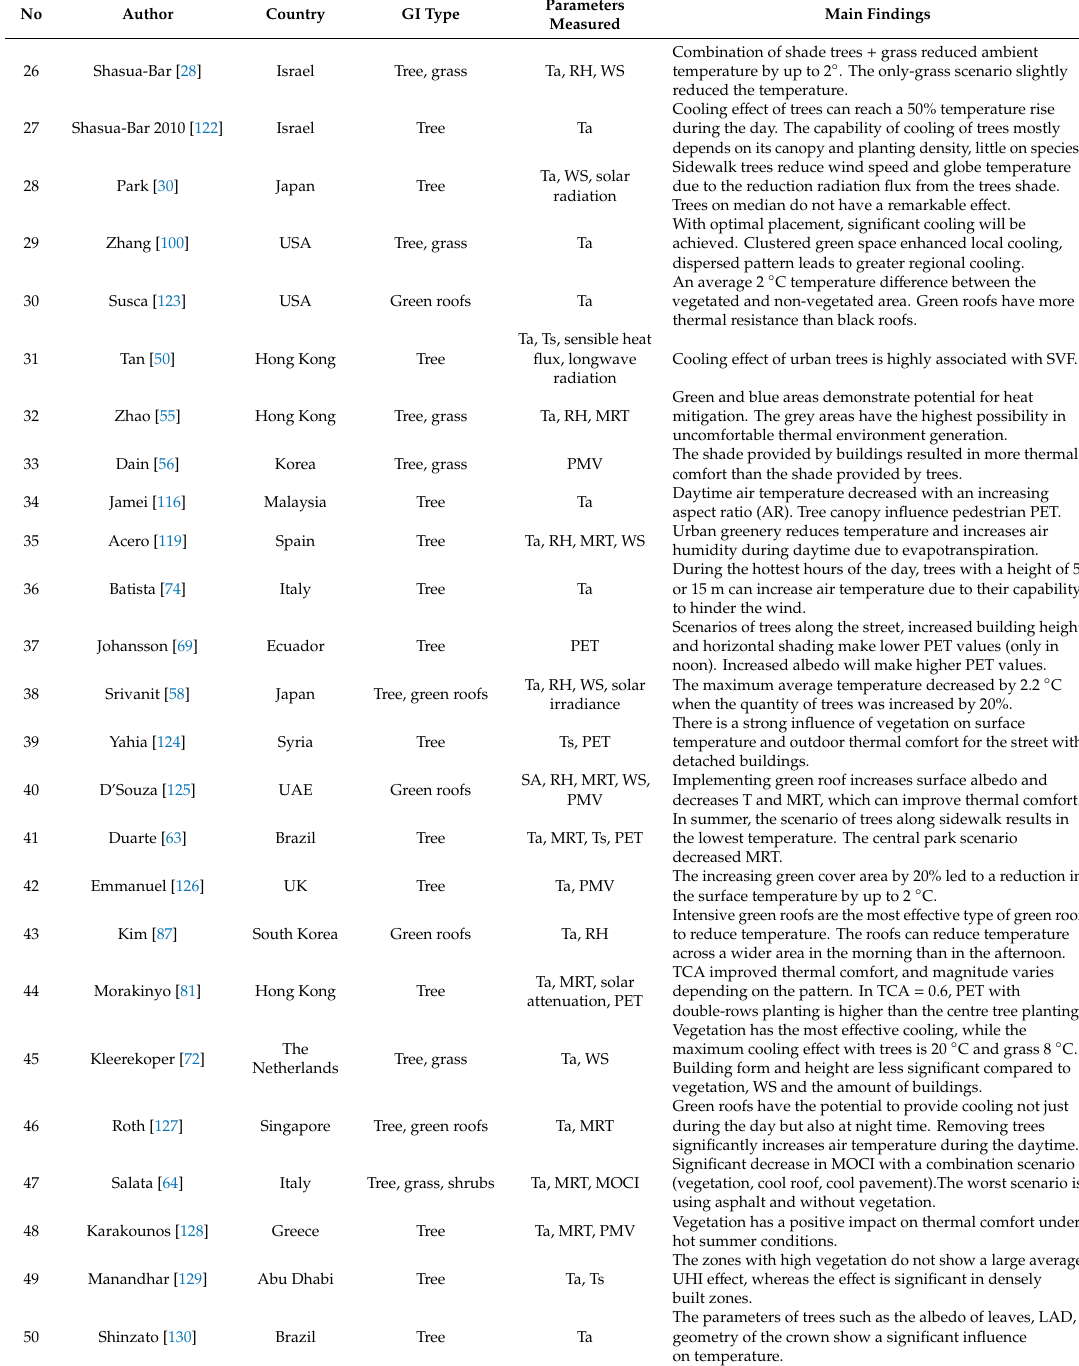
TCA improved thermal comfort, and magnitude varies Ta, MRT, solar depending on the pattern. In TCA = 0.6, PET with attenuation, PET double-rows planting is higher than the centre tree planting. Vegetation has the most e ff ective cooling, while the maximum cooling e ff ect with trees is 20 ◦ C and grass 8 ◦ C. Tree, grass Ta, WS Building form and height are less significant compared to vegetation, WS and the amount of buildings. Green roofs have the potential to provide cooling not just Ta, MRT during the day but also at night time. Removing trees significantly increases air temperature during the daytime. Significant decrease in MOCI with a combination scenario Ta, MRT, MOCI (vegetation, cool roof, cool pavement).The worst scenario is using asphalt and without vegetation. Vegetation has a positive impact on thermal comfort under hot summer conditions. The zones with high vegetation do not show a large average Tree Ta, Ts UHI e ff ect, whereas the e ff ect is significant in densely built zones. The parameters of trees such as the albedo of leaves, LAD, Tree Ta geometry of the crown show a significant influence on